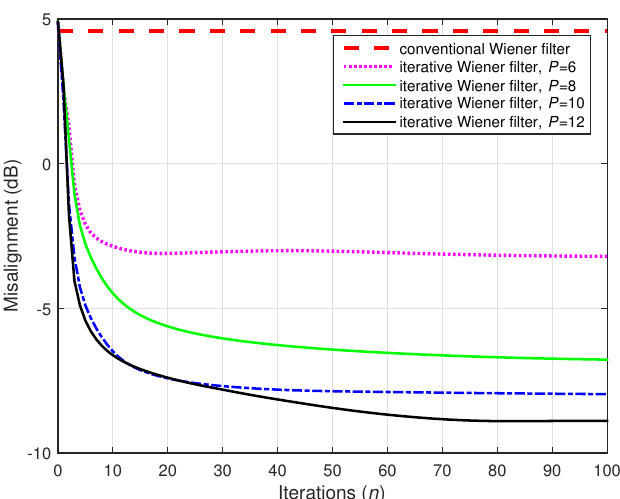
Figure 21. Performances of the conventional and iterative Wiener filters, using N = 2500. The source signal (white Gaussian noise) was preprocessed with positive and negative half-wave rectifiers, using α = 0.3. The numbers of channels were M = 2 (stereophonic scenario), L = 1024, and SNR = 30 dB.